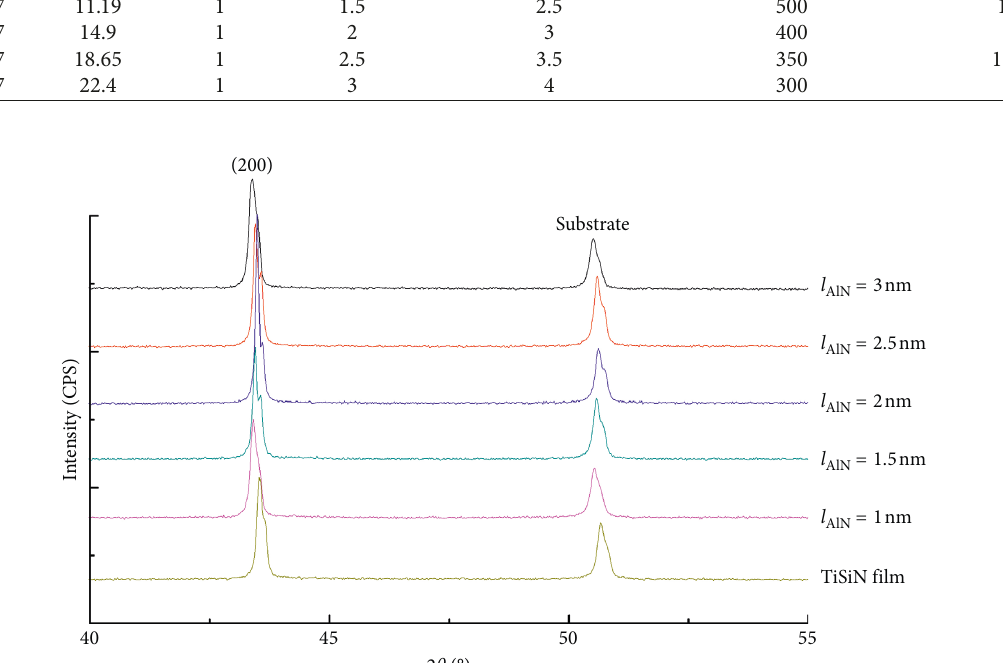
Figure 2: XRD patterns of TiSiN/AlN nanomultilayers and monolithic TiSiN film.